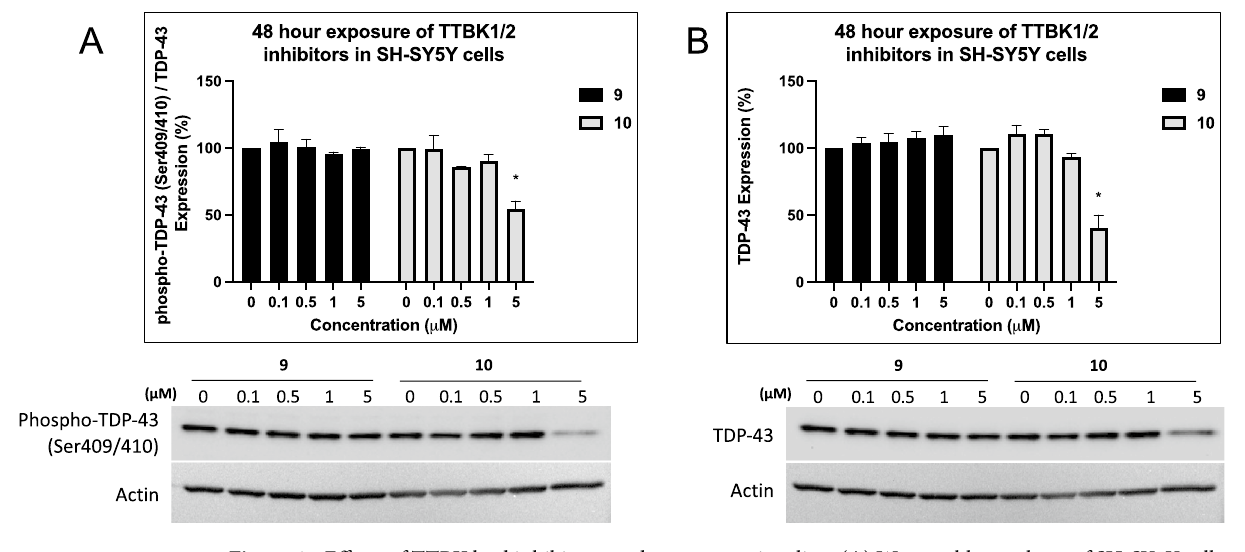
Figure 4. Effects of TTBK lead inhibitors on downstream signaling. ( A ) Western blot analyses of SH-SY5Y cells after 48 h treatment with 9 or 10 . Quantification of phospho-TDP-43 (Ser409/410, normalized to total TDP-43), n = 3. *control versus 5 µM 10 p -value = 0.0017. ( B ) Western blot analyses of SH-SY5Y cells after 48 h treatment with 9 or 10 . Quantification of total TDP-43, n = 3. *control versus 5 µM 10 p -value = 0.0001. Error bars represent SEM. P -values were generated using one-way ANOVA with Tukey correction. Unformatted images of blots are included in Fig.